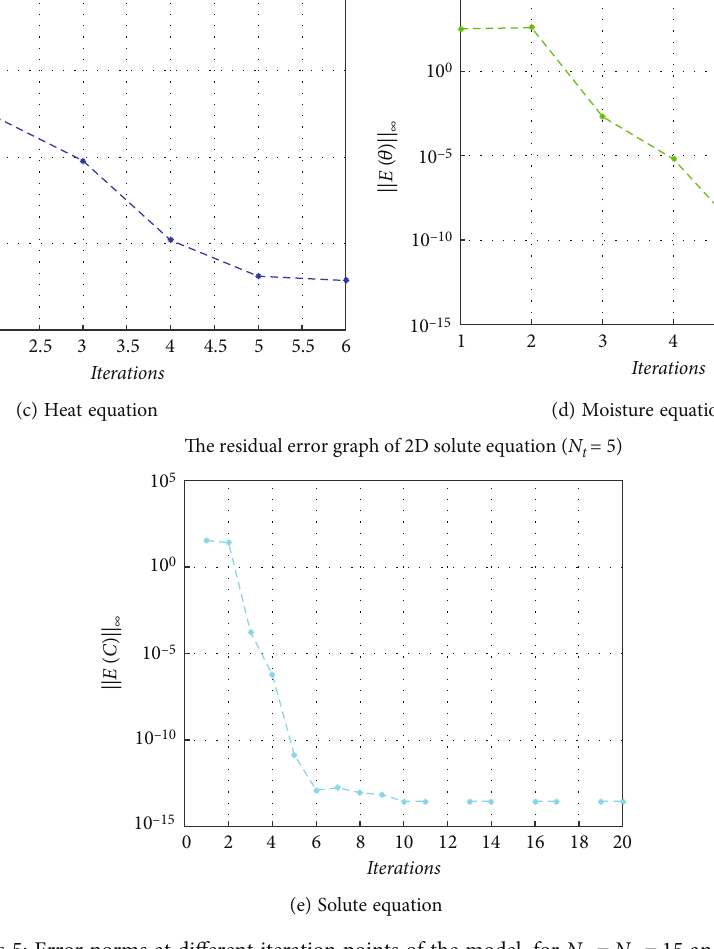
Figure 5: Error norms at di ff erent iteration points of the model, for N